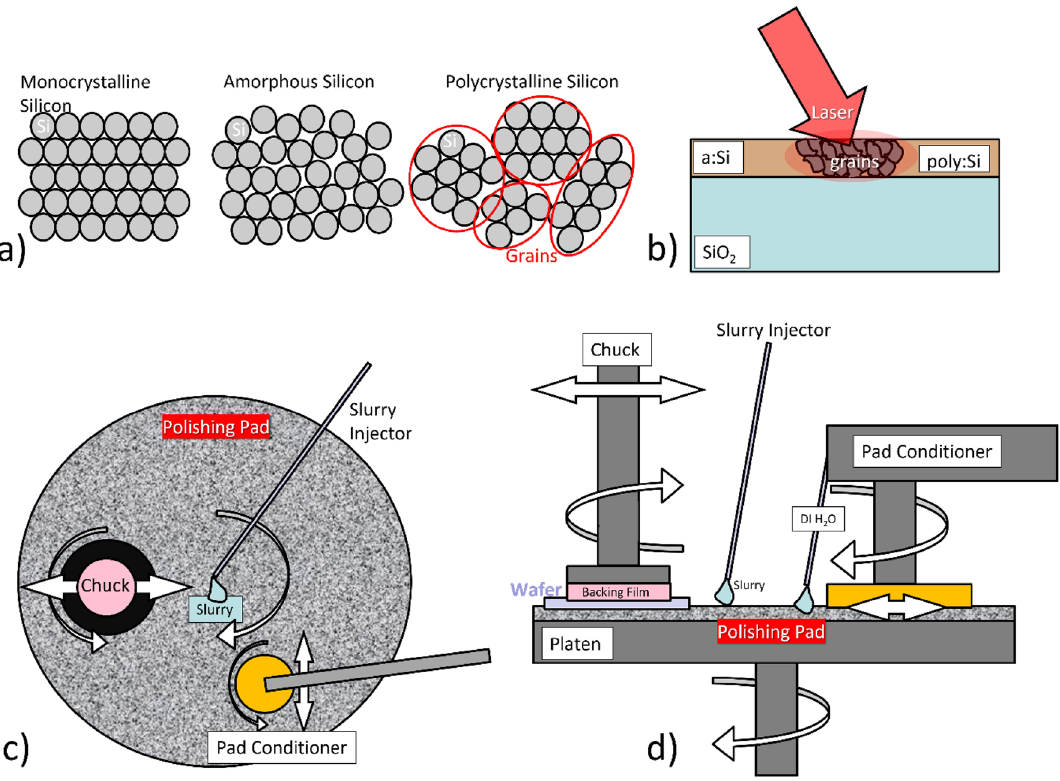
Figure 1. ( a ) Schematics of atomic arrangements in monocrystalline, amorphous and polycrystalline Silicon, ( b ) schematics of the laser annealing process, ( c ) schematics of the CMP process (top view) and ( d ) schematics of the CMP process (side